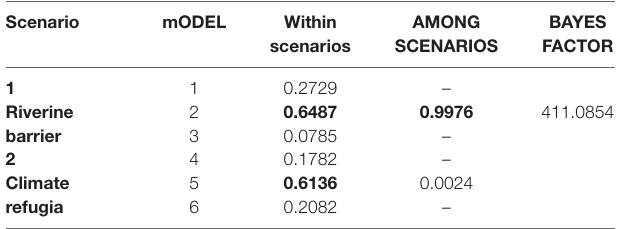
TABLE 5 | Results of the ABC model selection assuming two major scenarios for diversification in P. nordestinus lineages (Riverine barrier versus Climate refugia— Figure 2